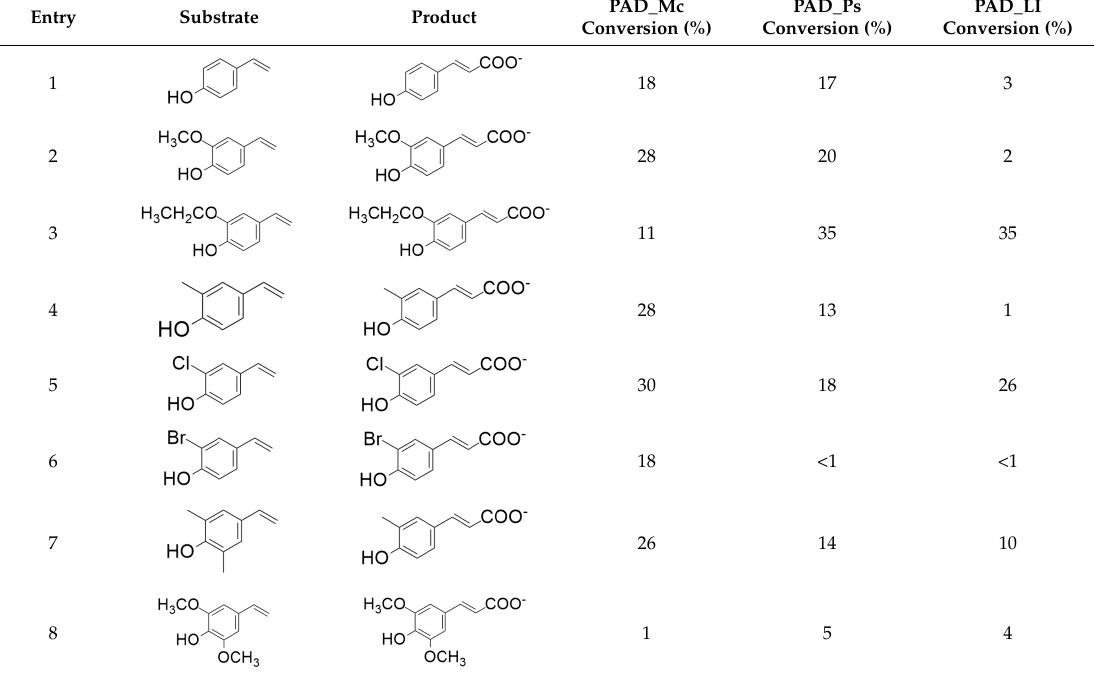
Figure 23. Proposed reaction mechanism for carboxylation of para -hydroxystyrene from PAD. Reproduced with permission from [87]. Copyright 2015, John Wiley and Sons.